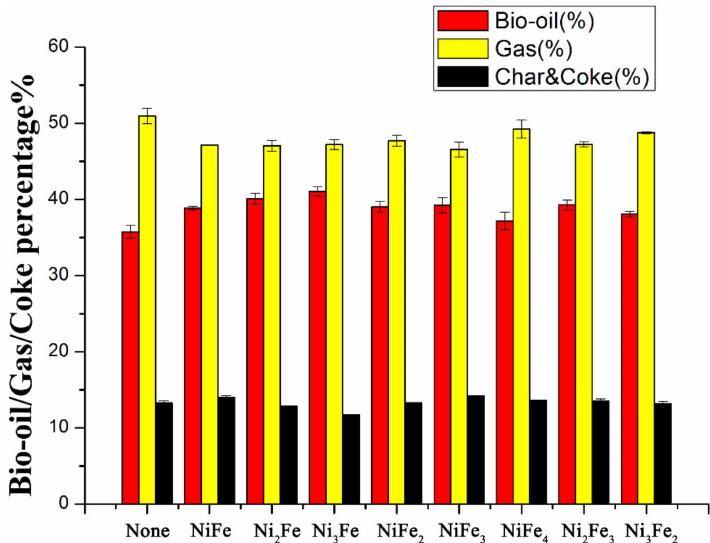
Figure 6. Yield of bio-oil, gas and char and coke without (none) and with di ff erent